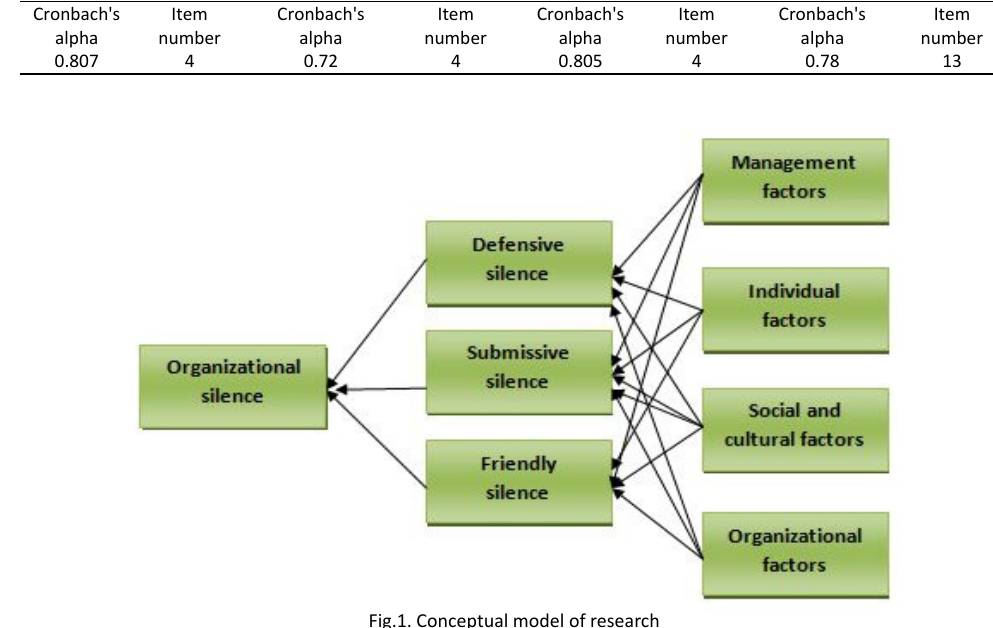
Fig.1. Conceptual model of